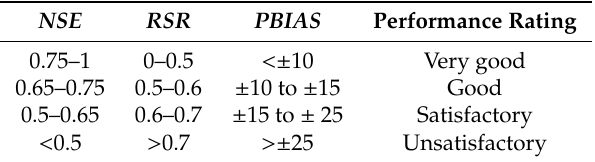
Figure A2. CDFs of annual changes in flow under ( a ) RCP4.5 and ( b ) RCP8.5 between the period 2041–2070 and 1975–2005, reflecting the uncertainty of SDSM and LARS-WG.